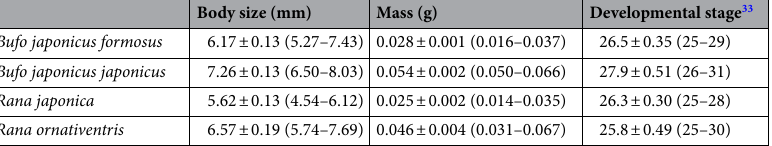
Table 1. Body sizes (mean ± standard errors, and range) and Gosner stages for tadpoles as measured at the beginning of the